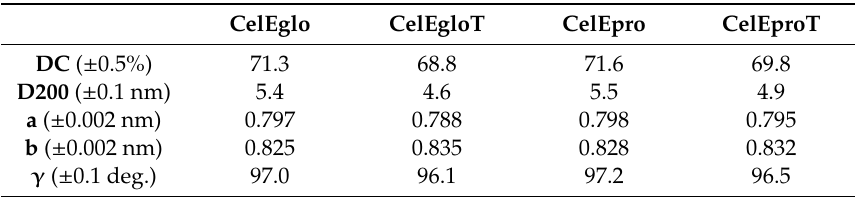
Table 4. Crystallinity, lateral dimension of crystallites and the crystallite cell parameters of cellulose assessed by wide angle X-ray scattering